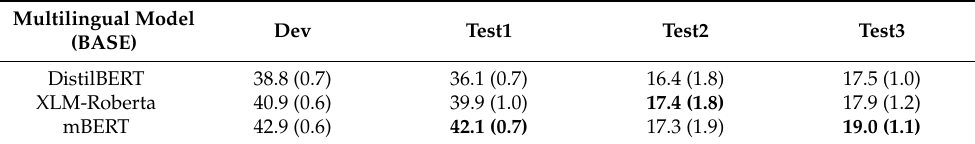
Table 6. Performance analysis of different pre-trained multilingual models.